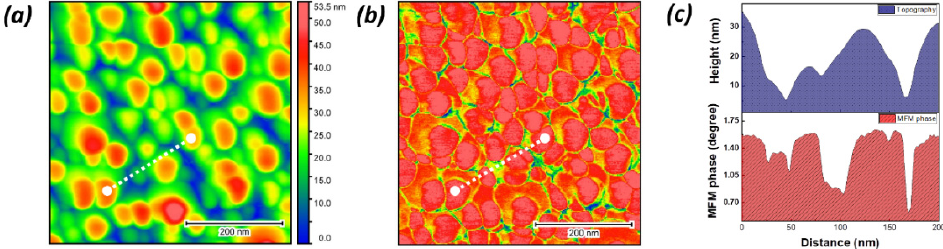
Figure 4. ( a ) AFM and ( b ) MFM images of the InZnP:Ag nano-rods annealed at 300 ◦ C. ( c ) AFM height profile and MFM phase obtained under diagonal scans along the dashed line drawn in ( a ) and ( b ).